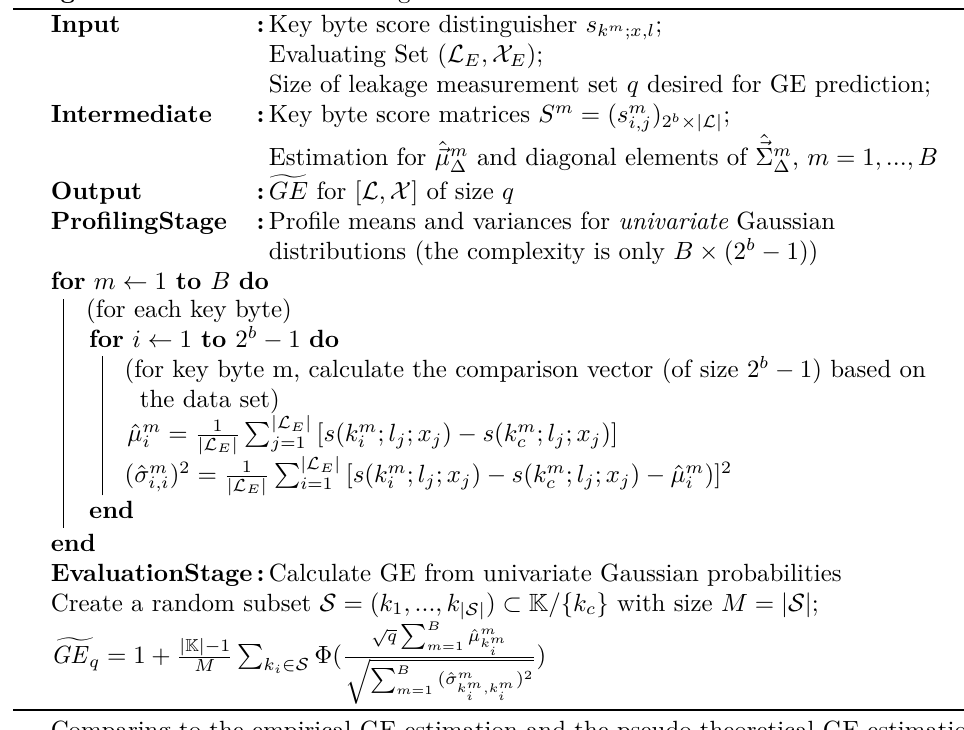
Algorithm 1: GE Estimation